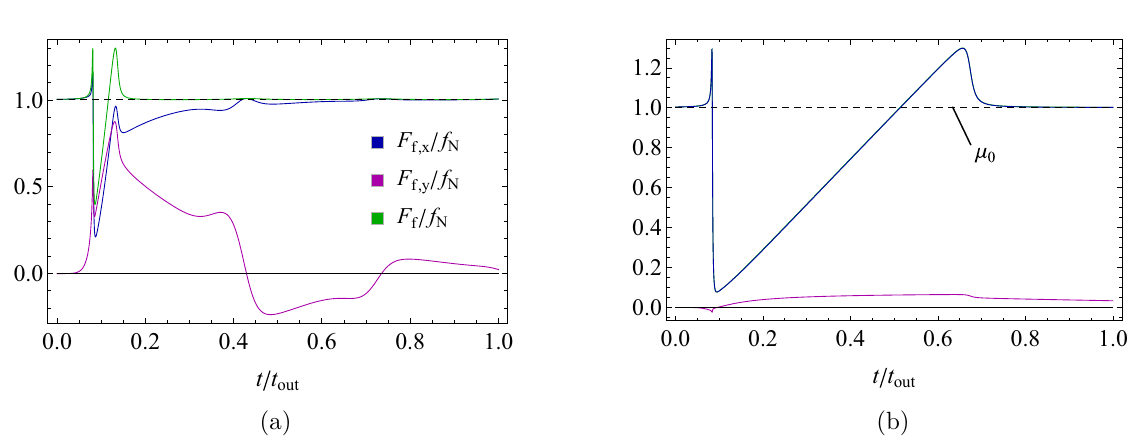
Figure 7. The friction time-history during sliding of a single elastic support with θ 0 = π/ 2 . Results are for ( a ) pendulum regime with ˜ k r = 3 and ˜ k θ = 0.01 and ( b ) soft regime with ˜ k r = 0.03 and ˜ k θ = 0.03 . Moreover, ˜ F N =